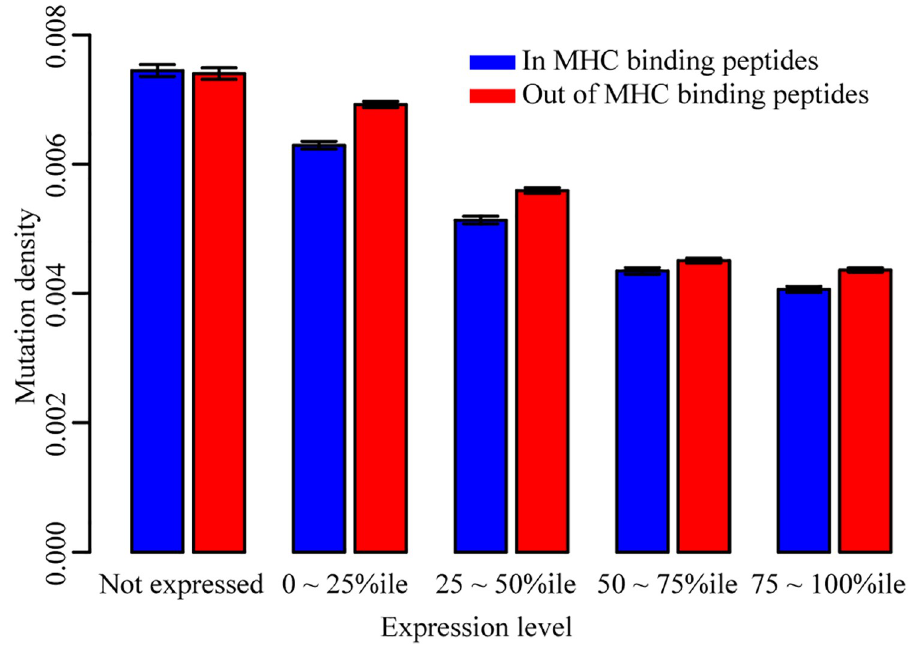
Fig 1. MHC-display-dependent mutation densities for genes with different expression levels. Blue bars are the mutation density within the predicted MHC binding peptides. Red bars are the mutation density out of the predicted MHC binding peptides. Mutations were separated into five categories based on the expression levels of their